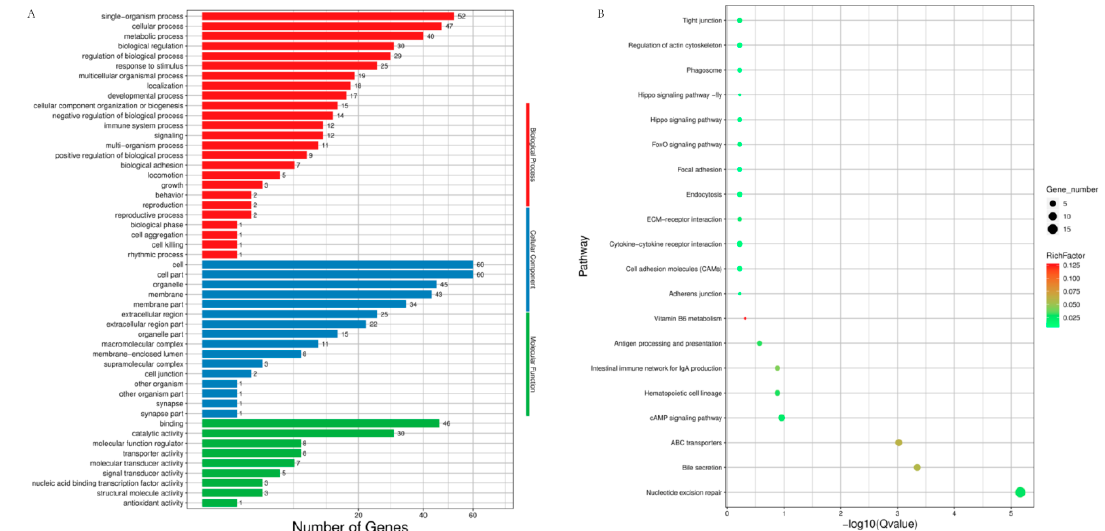
Figure 3. Functional annotation for the differentially expressed genes (DEGs). ( A ) Summary of Gene Ontology (GO) analysis present under three categories: molecular function, cellular component, and biological process; ( B ) The top 20 enriched Kyoto Encyclopedia of Genes and Genomes (KEGG) pathways for DEGs. Rich factor: the ratio of the number of genes divided by the number of all the genes in each pathway. Gene number: number of genes in each pathway.